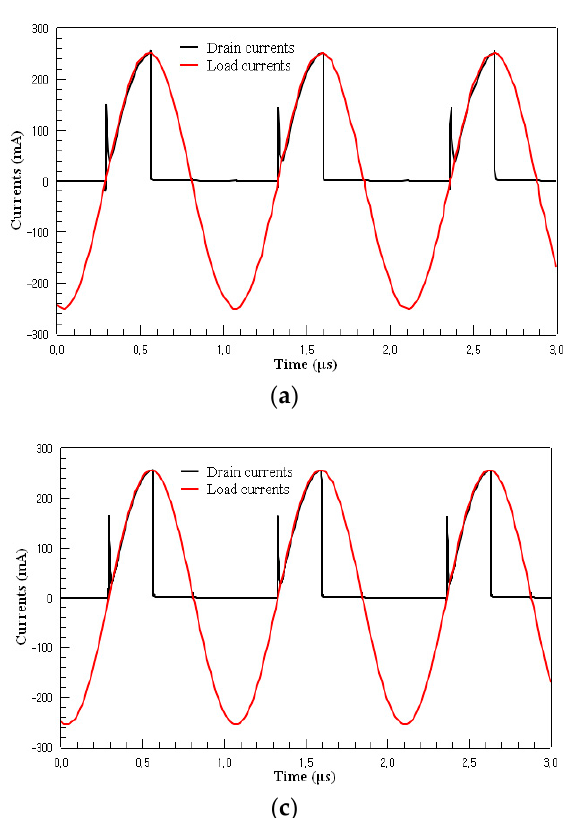
Figure 4. Waveforms of the PMOS drain currents and the load currents for P conduction and P S calcula- tions: ( a ) thick gate oxide, ( b ) mid gate oxide, ( c ) thin gate oxide. calculations: ( a ) thick gate oxide, ( b ) mid gate oxide, ( c ) thin gate